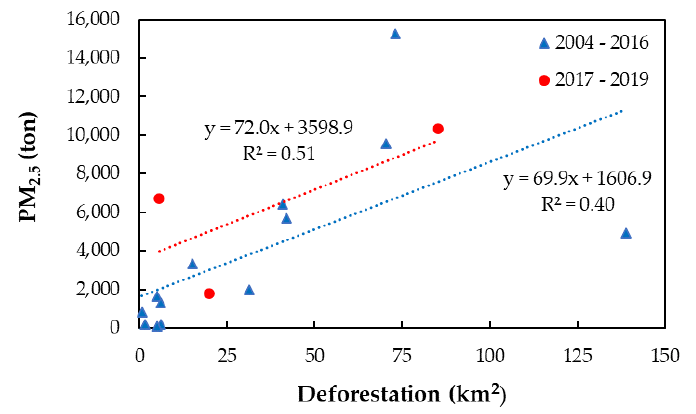
Figure 5. Correlation between annual total estimated emission of PM 2.5 and annual deforestation rates in the Apyterewa Indigenous Land during 2004–2016 and 2017–2019.